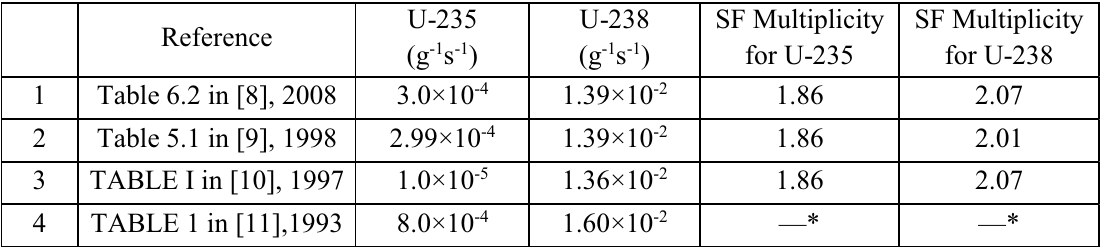
Table I. SF Neutron Emission Rates and SF Multiplicity for U-235 and U-238